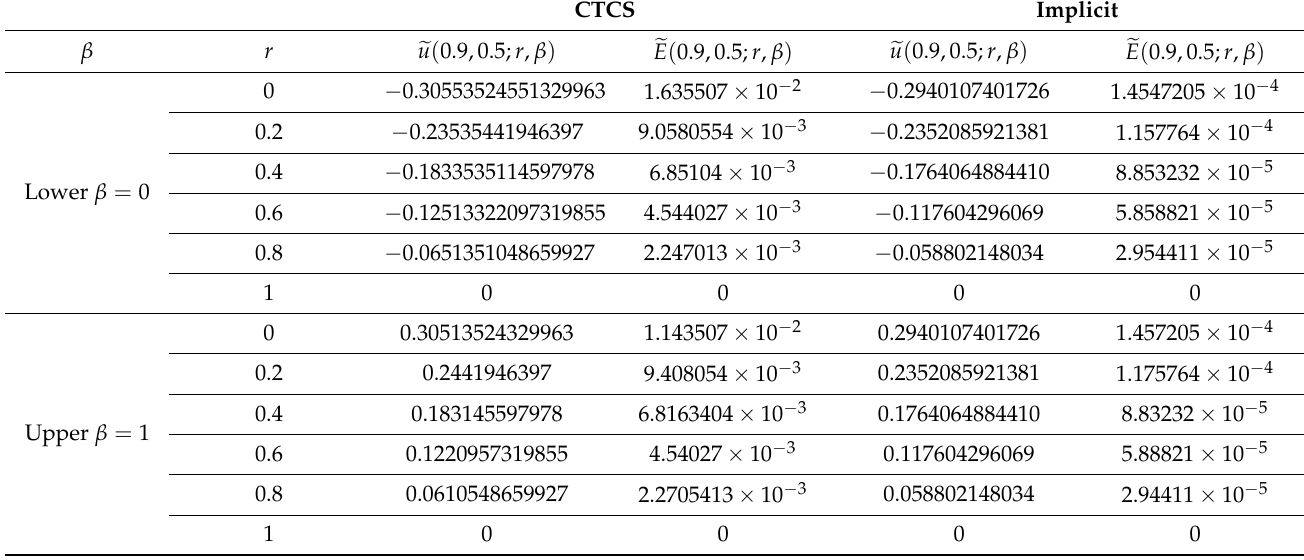
Table 3. Numerical solution of Equation (33) by CTCS and implicit at t = 0.05 and x = 0.9 for r , β ∈ [ 0,1 ] .